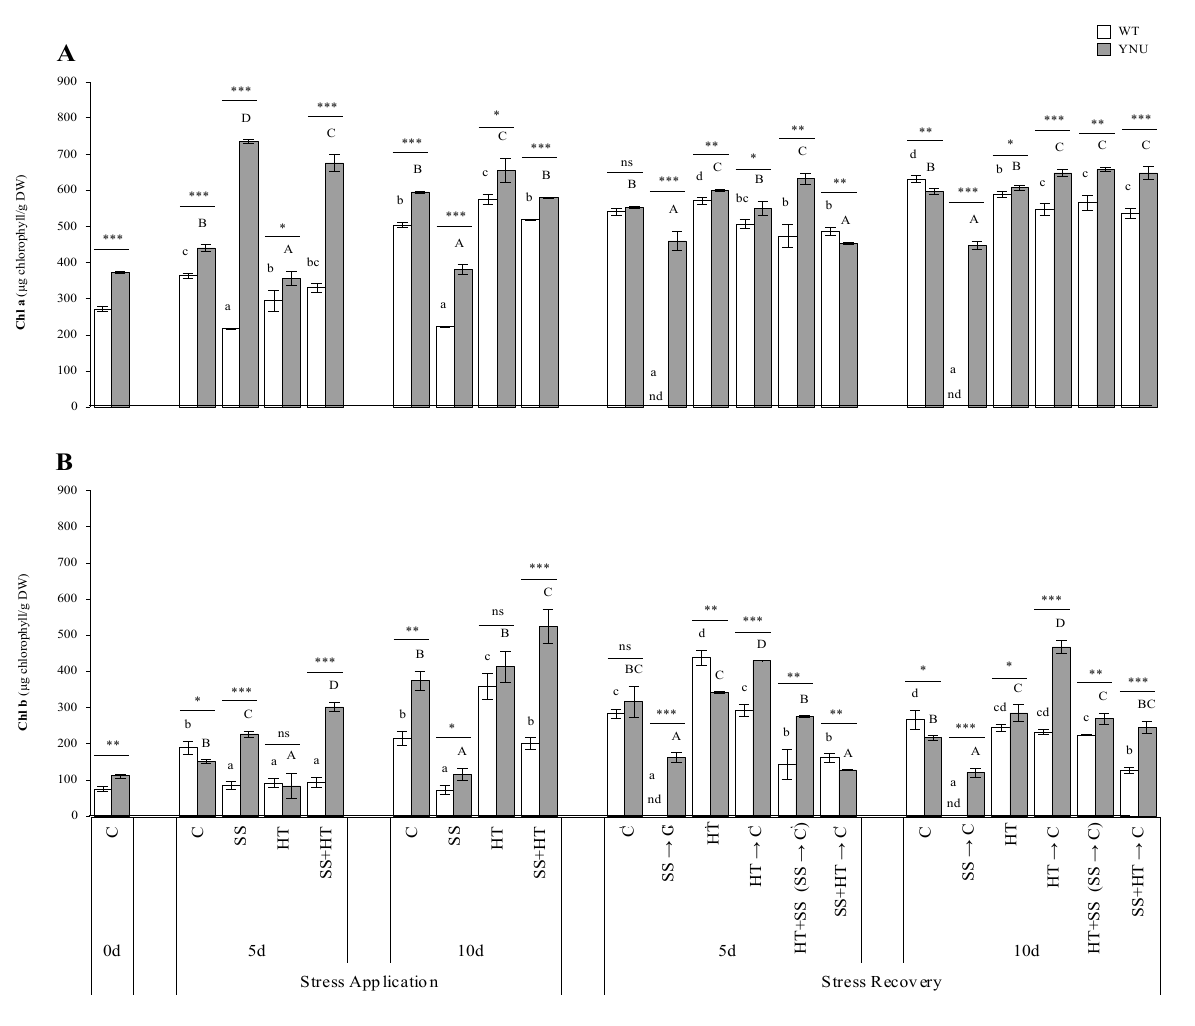
Figure 2. Chlorophyll content of rice seedlings under salinity (SS), high-temperature (HT), and combined salinity and heat (SS + HT) conditions; ( A ) Chlorophyll a (Chl a) and ( B ) chlorophyll b (Chl b) content of WT and YNU plants under control (C: 26/23 °C, 0 mM NaCl), salt stress (SS: 26/23 °C, 75 mM NaCl), high-temperature (HT: 30/26 °C, 0 mM NaCl), and combine stress (SS + HT: 30/26 °C, 75 mM NaCl) conditions. Values represent the means ± SE determined from three independent experiments using 4 plants in each experiment. Means within the same graph followed by different lowercase (WT) and uppercase (YNU) letters are significantly different at p < 0.05 according to the Tukey’s HSD test. Asterisks represent statistical significance of difference using Student’s t -statistic with *** p < 0.001, ** p < 0.01, * p < 0.05, ns: non-significant.